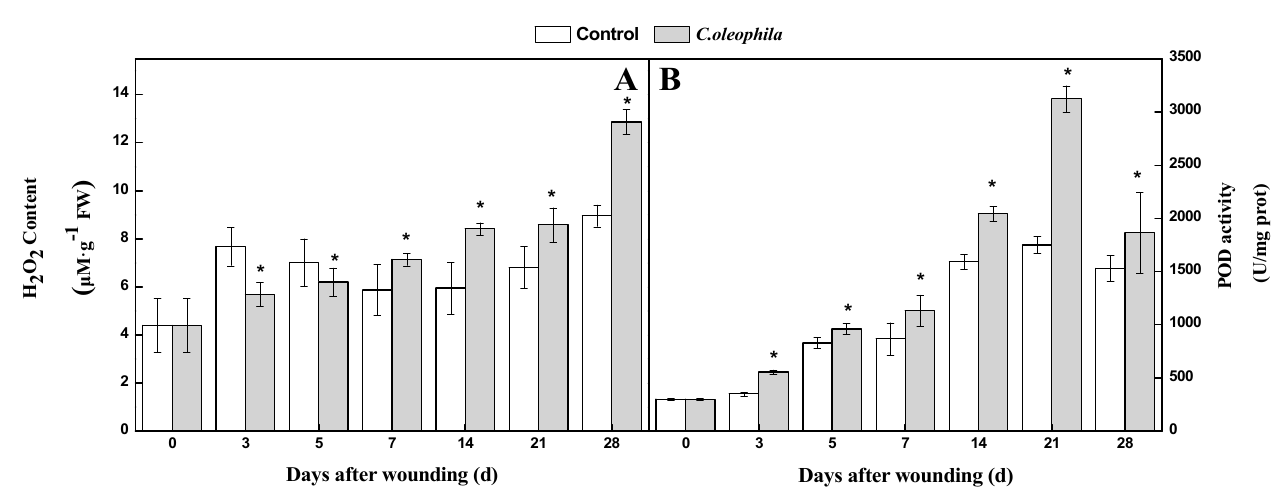
Figure 6. Effects of C. oleophila treatment on the content of H 2 O 2 ( A ) and the activity of POD ( B ) at wound sites of tubers during healing. Bars indicate standard error ( ± SE). Asterisks indicate significant difference ( p < 0.05).